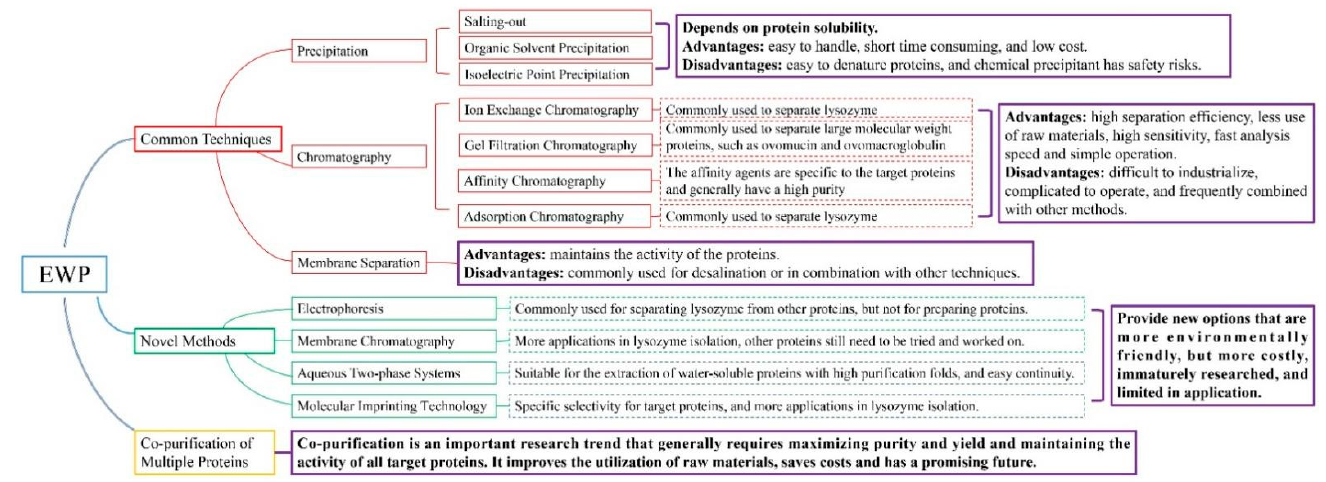
Figure 2. Summary of the separation methods of EWP.